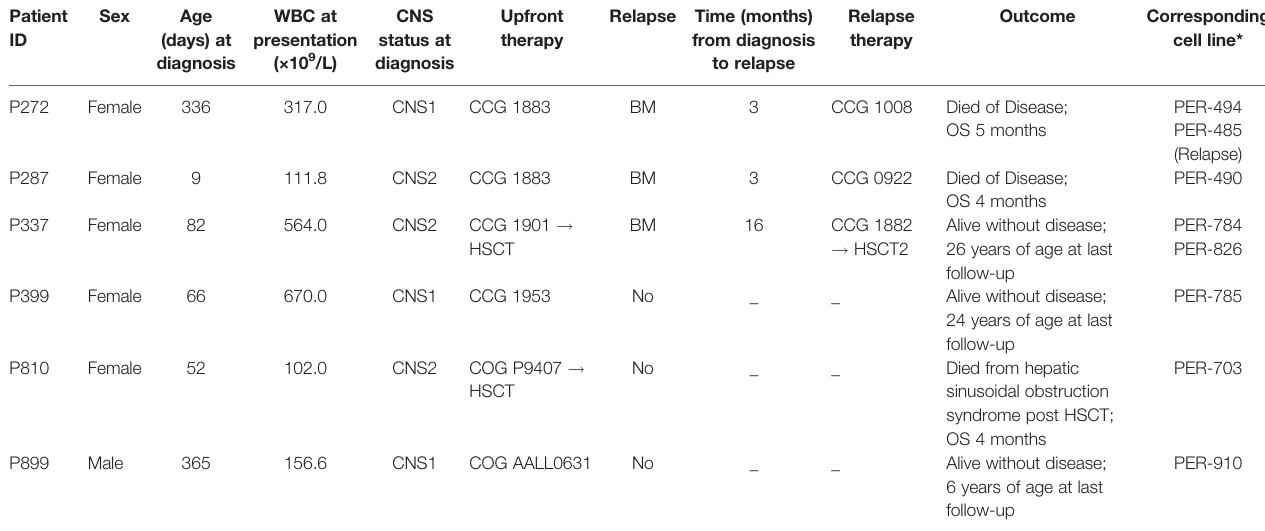
TABLE 1 | Clinical characteristics of six infants with KMT2A -rearranged acute lymphoblastic leukemia and corresponding cell lines. Patient